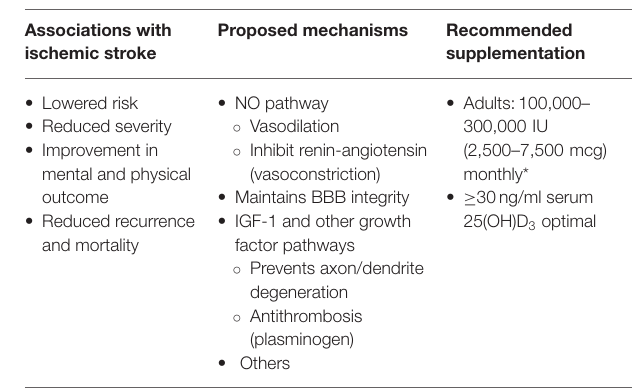
TABLE 1 | Summary of vitamin D benefits, mechanisms,